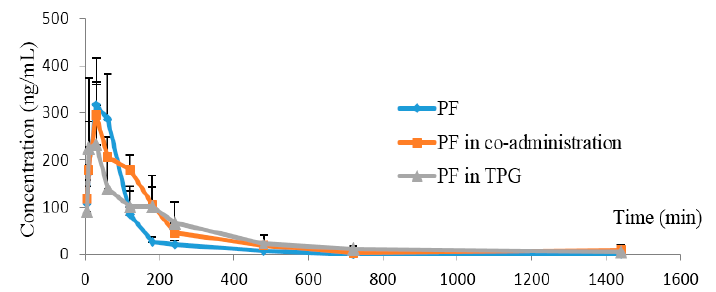
Figure 3. The mean plasma concentration–time profiles of paeoniflorin (PF) in rat. PF was administered orally to rats alone, PF combined with albiflorin, and PF in TPG groups. The values are the mean ± SD, n = 6.